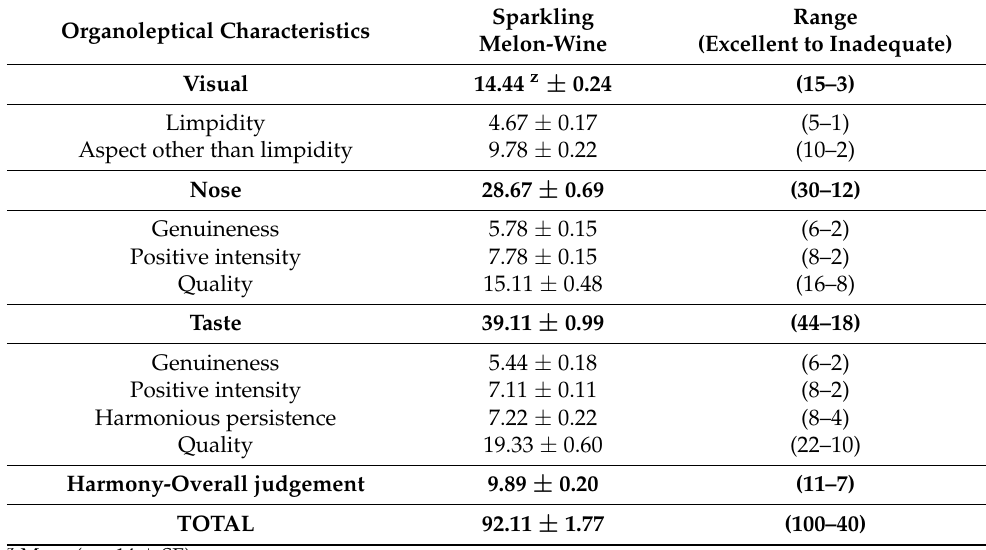
Table 8. Sensory evaluation of the melon sparkling wine at 10 weeks of